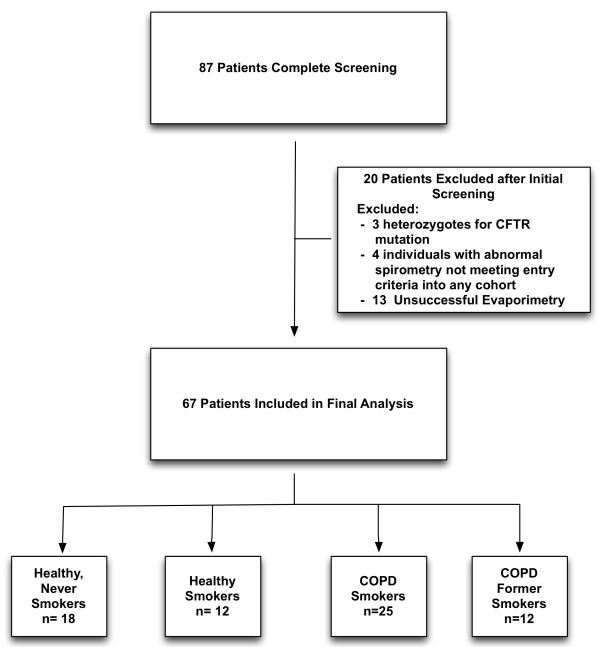
Subject disposition.